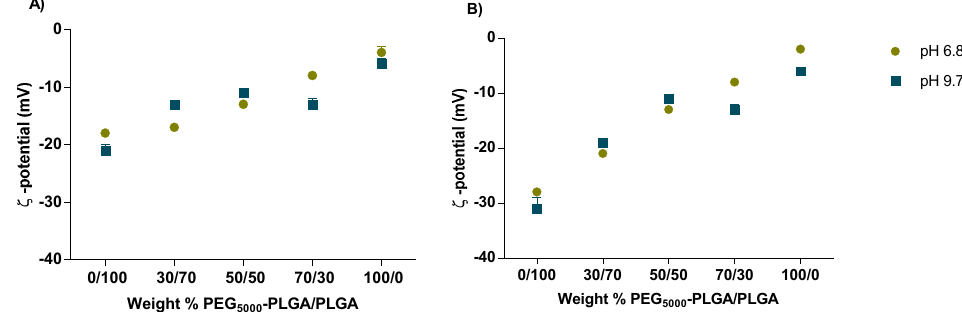
Figure 4. ζ -potential of FS10-loaded nanoparticles prepared by double emulsion ( A ), and nanopre- cipitation method ( B ) at pH 6.8 and 9.7. All measurements were performed in triplicate (n = 3) for every single batch.